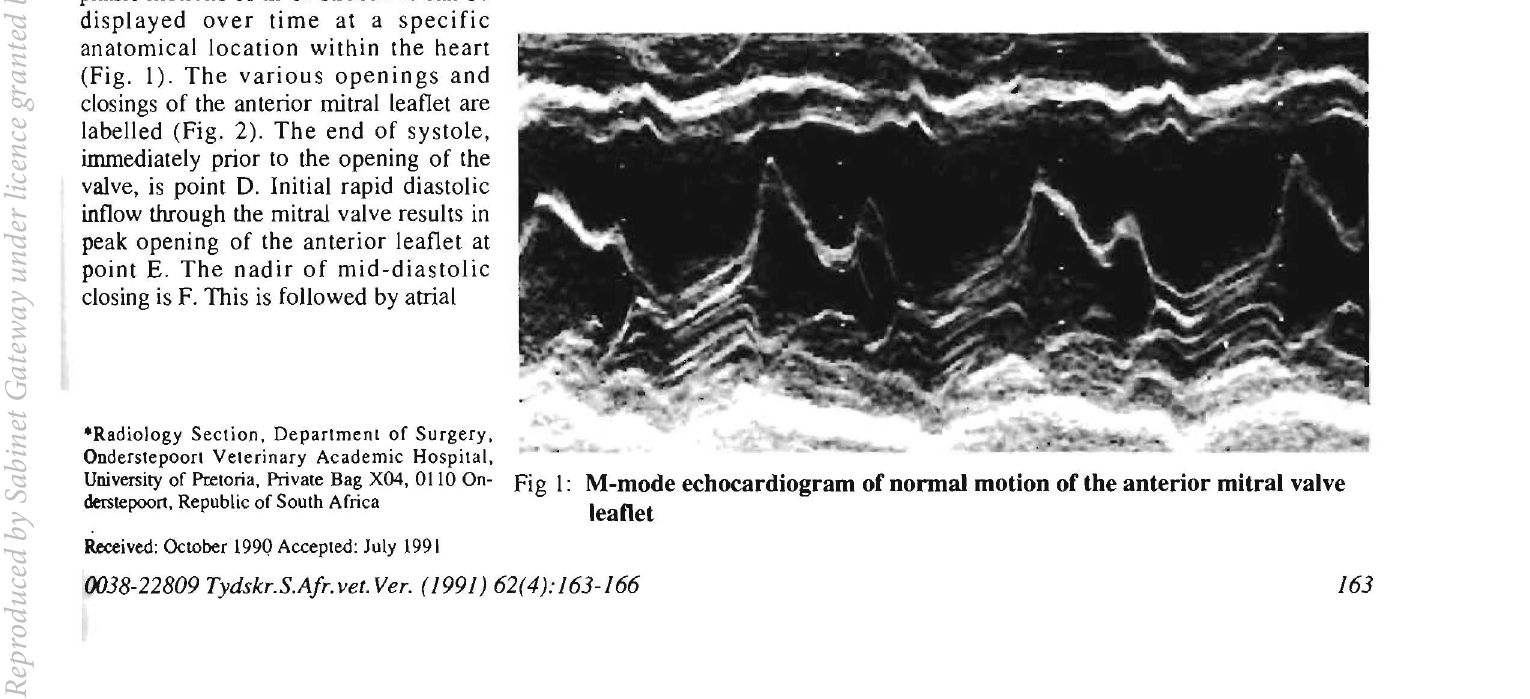
Fig I: M-mode echocardiogram of normal motion of the anterior mitral valve